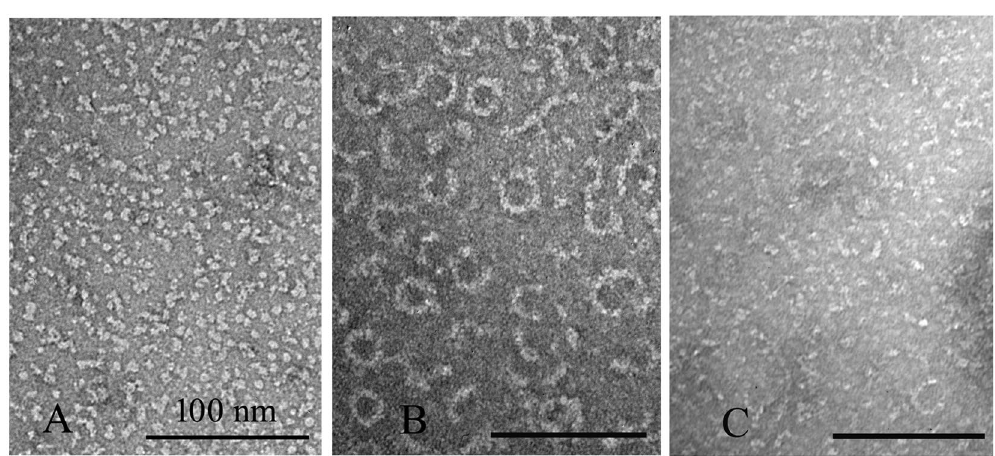
Figure 3. EM images of 5 µ M FtsZ ( A ), 5 µ M FtsZ plus 5 µ M ZipA ( B ) and 15 µ M FtsZ ( C ) assembled at pH 7.5 in 0.5 mM GDP. Bar is 100